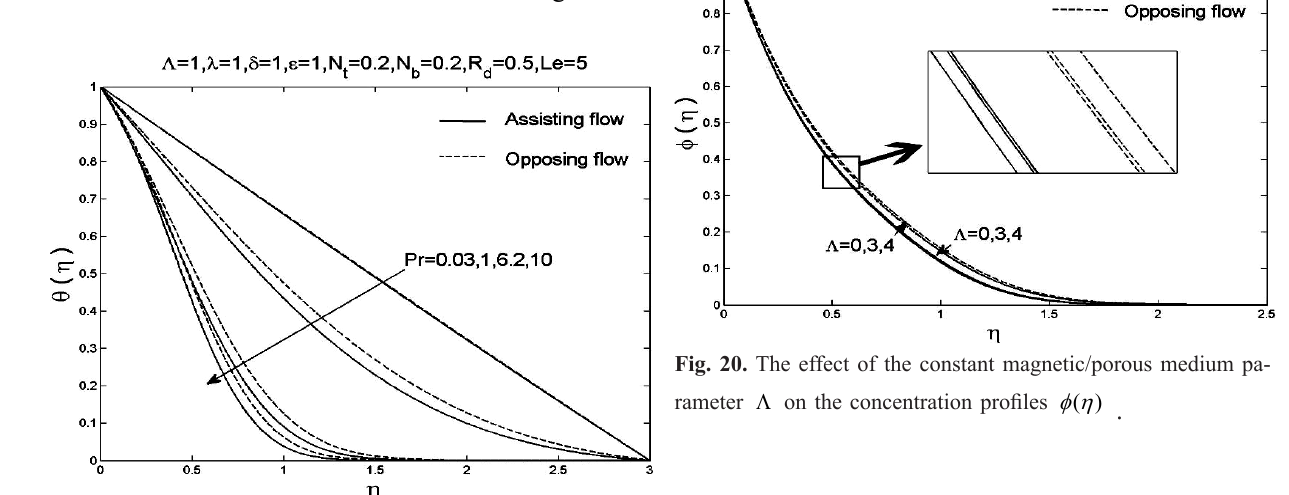
Fig. 19 . The effect of the lewis number Le on the temperature profiles ( ) θη .